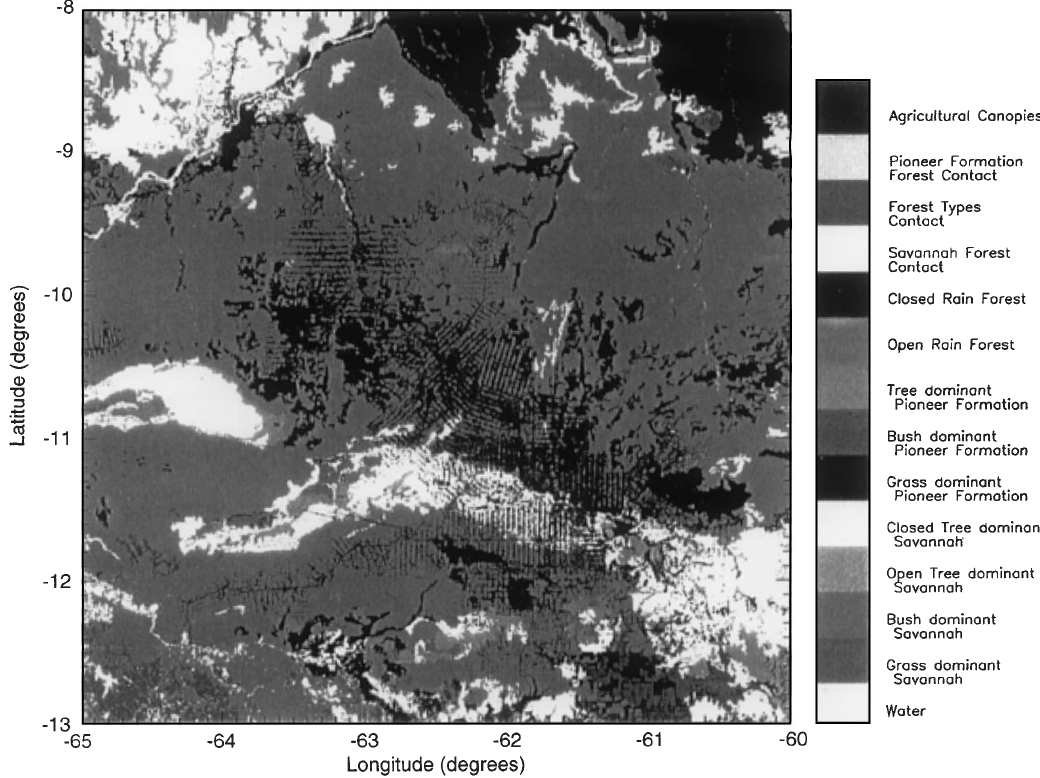
Fig. 2. Land cover classification derived from LANDSAT imagery and RADAMBRASIL vegetation